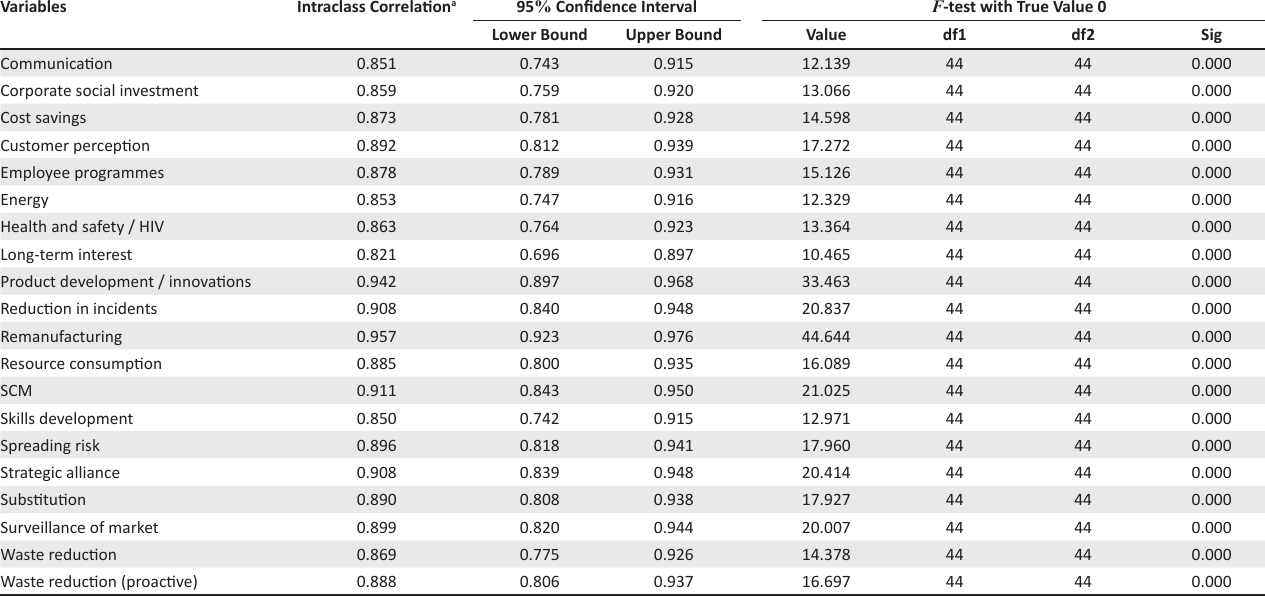
TABLE 4: Results of test of interrater reliability for ‘Sig’ dependent variables.